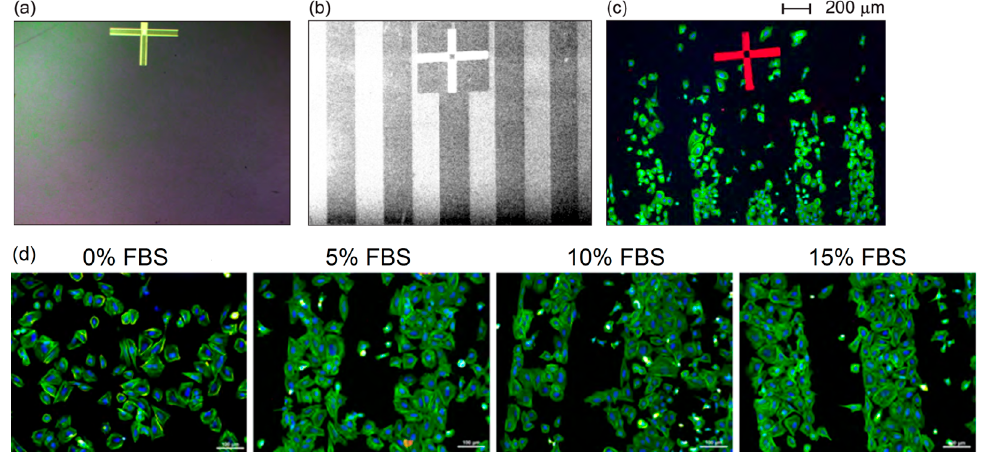
Figure 3. NCD film with 200 µm wide H/O-terminated patterns: ( a ) optical (bright field) image prior to cell plating showing optically transparent and featureless surface, ( b ) SEM image prior to cell plating where bright stripes correspond to H-termination and dark stripes to O-termination of the diamond surface due to their opposite electron affinity. Fluorescent microscopy images of osteoblastic cells (SAOS-2) cultivated on the substrate, showing ( c ) the alignment cross for correlation of the surface termination micro-patterns with the cells, and ( d ) cell growth, after 2 days of incubation, on 200 µm H/O-terminated stripes on diamond films in McCoy’s medium supplemented with different foetal bovine serum (FBS) concentrations (0, 5, 10, and 15%). Reproduced from Rezek et al . [15]